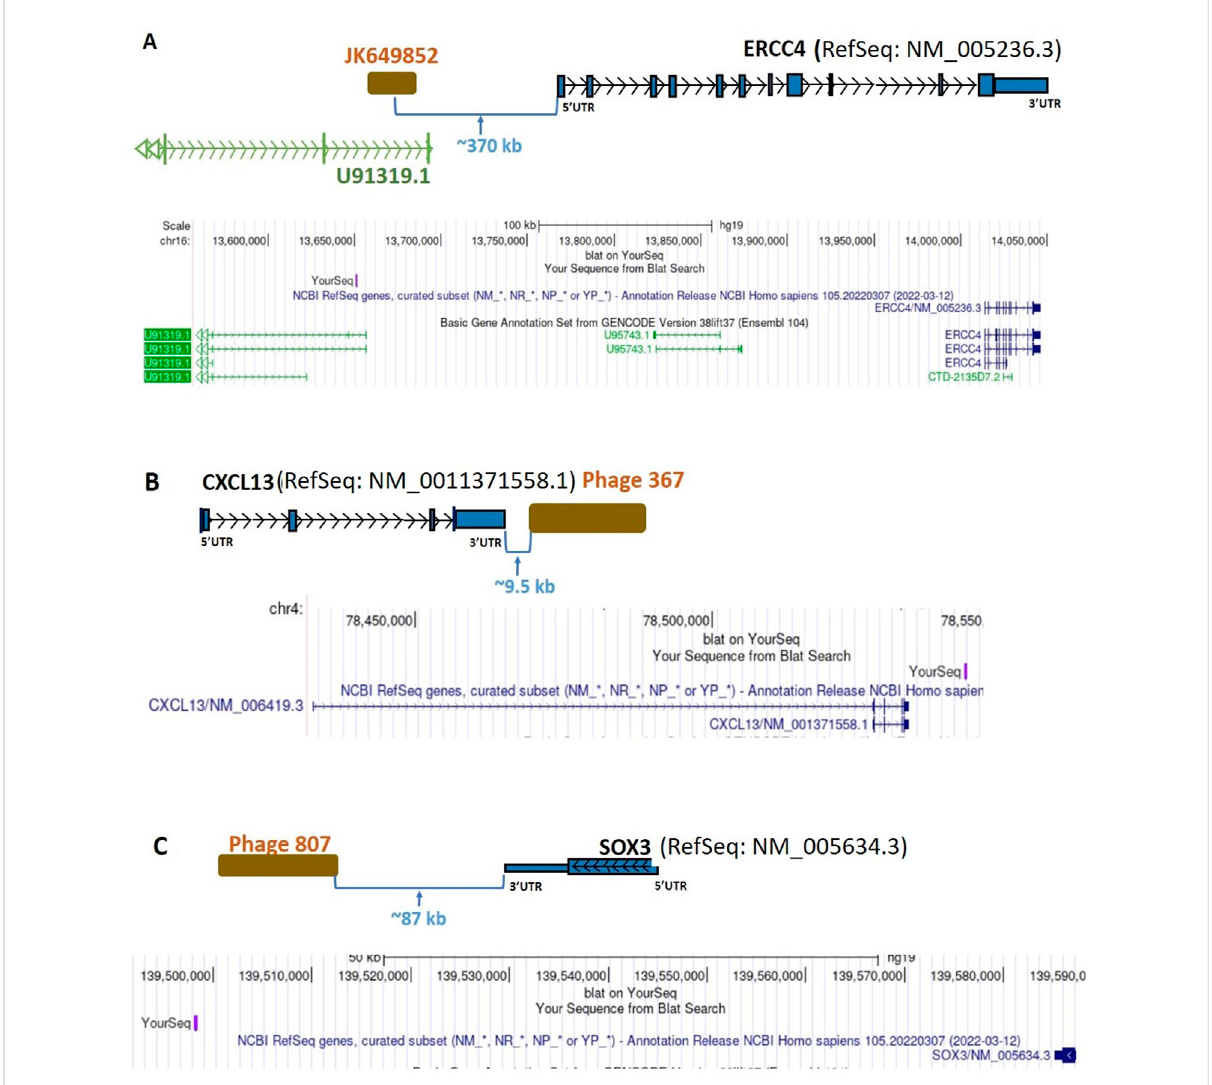
FIGURE 6 Diagrammatic representation of intergenic sequence mappings of the inserts of uniquely BC-patient-sera-reactive, cDNA-library-derived phagesclose tothegenes ERCC4 , CXCL13 ,and SOX3 . (A) PhageJK649852, anintergenicphage,closetothecodinggene ERCC4 . (B) Phage367,an intergenicphage,closeto CXCL13 codinggene. (C) Phage807,anintergenicphage,closetothe SOX3 codinggene. ERCC4 ,ERCCExcisionRepair4; CXCL13 , C-X-C Motif Chemokine Ligand 13; SOX3 , SRY-Box Transcription Factor 3; UTR, untranslated region; kb,